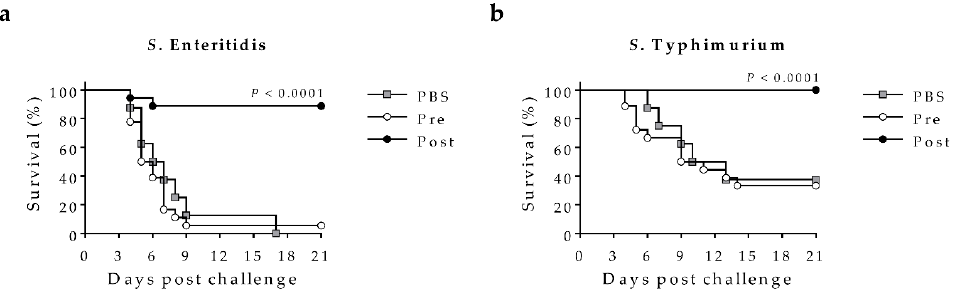
Figure 5. Protection against fatal iNTS infection in mice after passive transfer of trivalent vaccine-induced rabbit antisera. Mice were passively administered PBS ( n = 8/group, grey squares) or pooled and diluted trivalent rabbit sera ( n = 18/group), that were obtained either pre-immunization (white circles) or post-vaccination (black circles). Passively-immunized mice were then challenged with ( a ) 1 × 10 6 CFU of S . Enteritidis R11 or ( b ) 1 × 10 5 CFU of S . Typhimurium D65. The Kaplan–Meier survival curves for the respective pre- and post-immune sera were compared using log-rank analysis, for which P values are indicated.